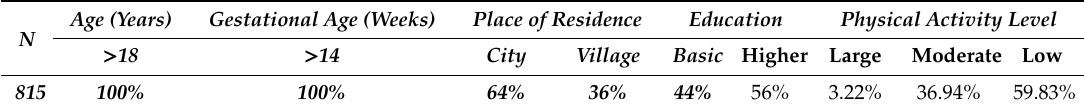
Table 1. Characteristics of the group of pregnant women participating in the